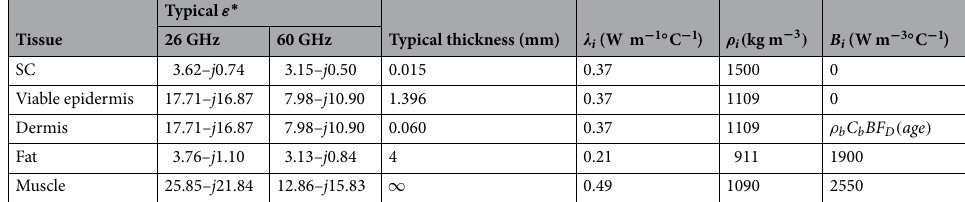
Table 1. Typical permittivities and thicknesses of tissues, thermal conductivity, mass density and blood perfusion.